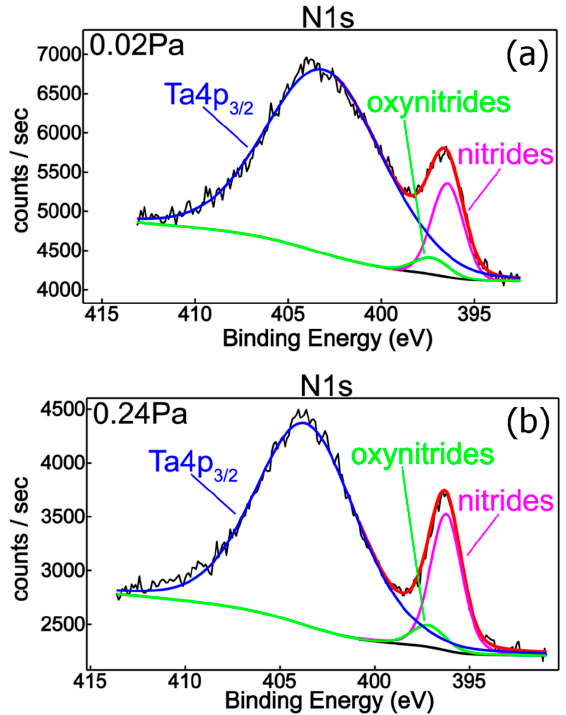
Figure 5. XPS deconvoluted N1s spectrum for samples obtained with different reactive gas mixture partial pressures: ( a ) 0.02 Pa; ( b ) 0.24 Pa.